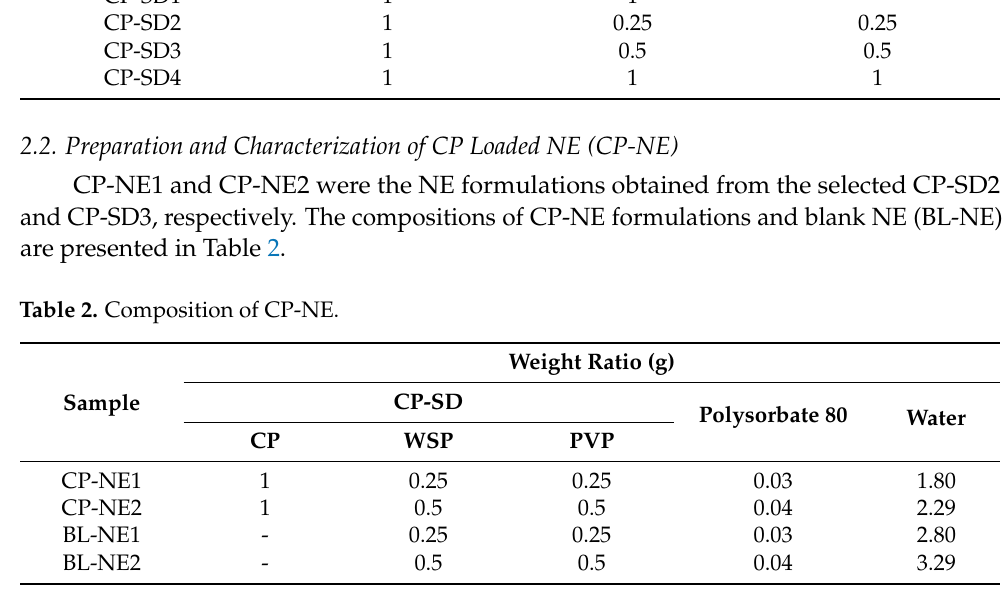
Table 2. Composition of CP-NE.